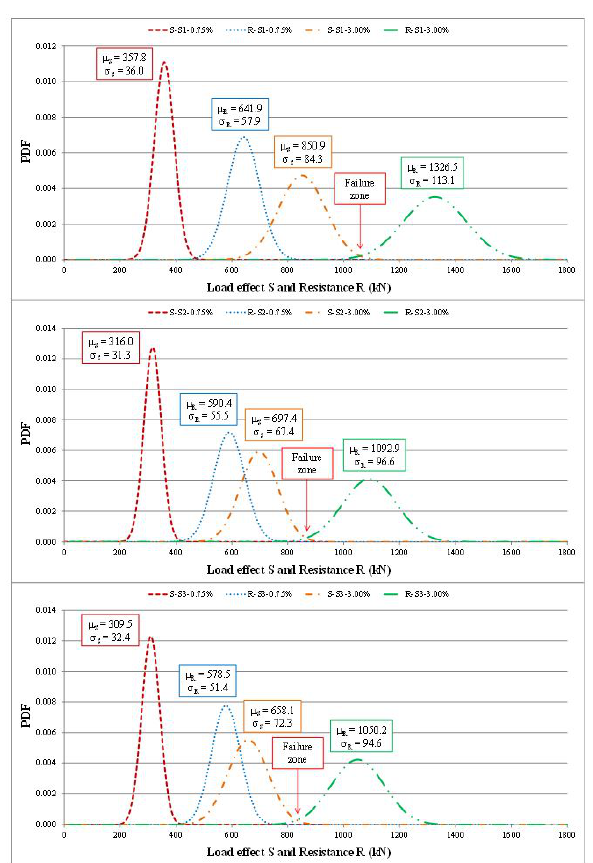
Figure 15. Analysis of load effect and resistance by probability density function